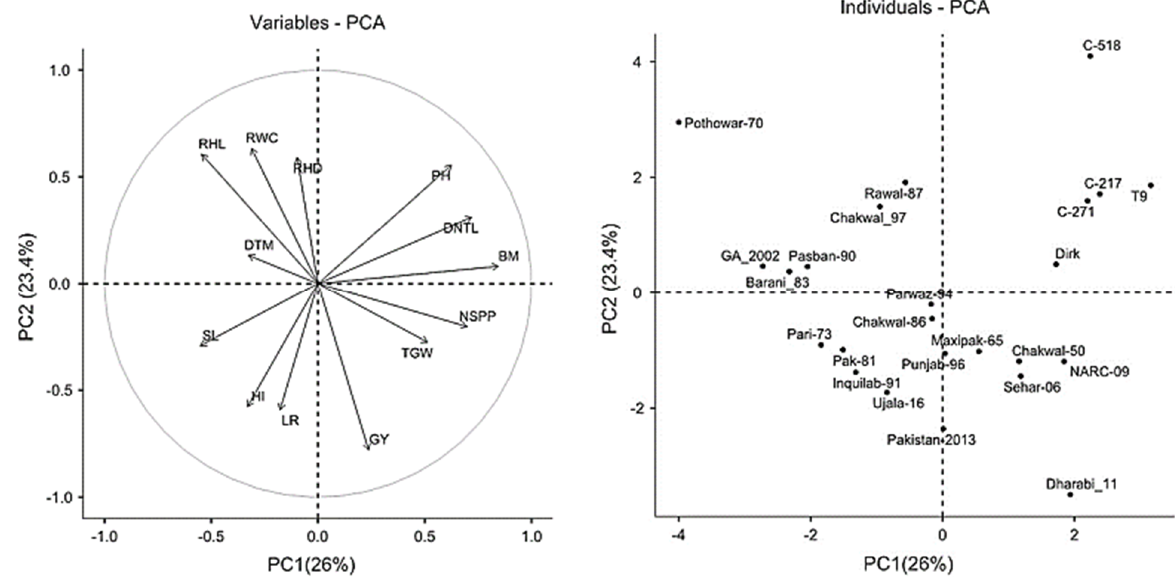
Figure 2. The PCA plot showing the loading of variables (root hair length and root hair density on left) and the scores of each variety (right). Points closer together correspond to cultivars having similar scores on the PCA components.